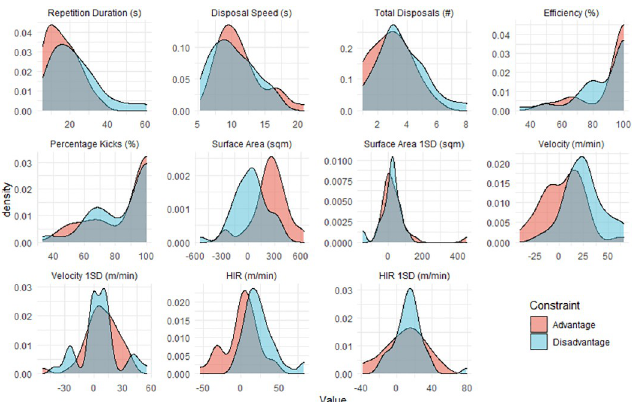
Fig 1. Distribution of each behaviour metric within advantage (red) and disadvantage (blue) constraint conditions.